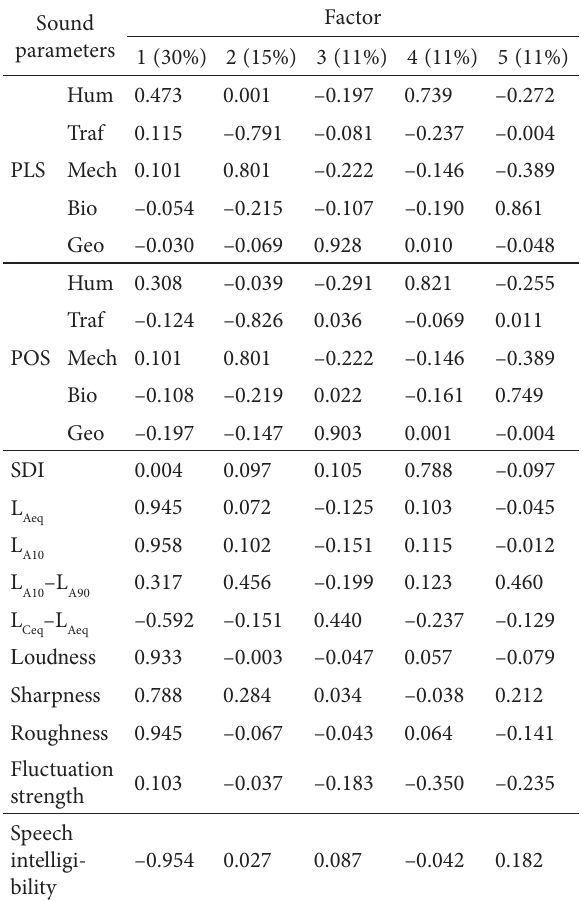
Table 2. Factor analysis of all the soundscape parameters (overall results of all the five city parks), cumulative %: 78; extraction method: principal component analysis;